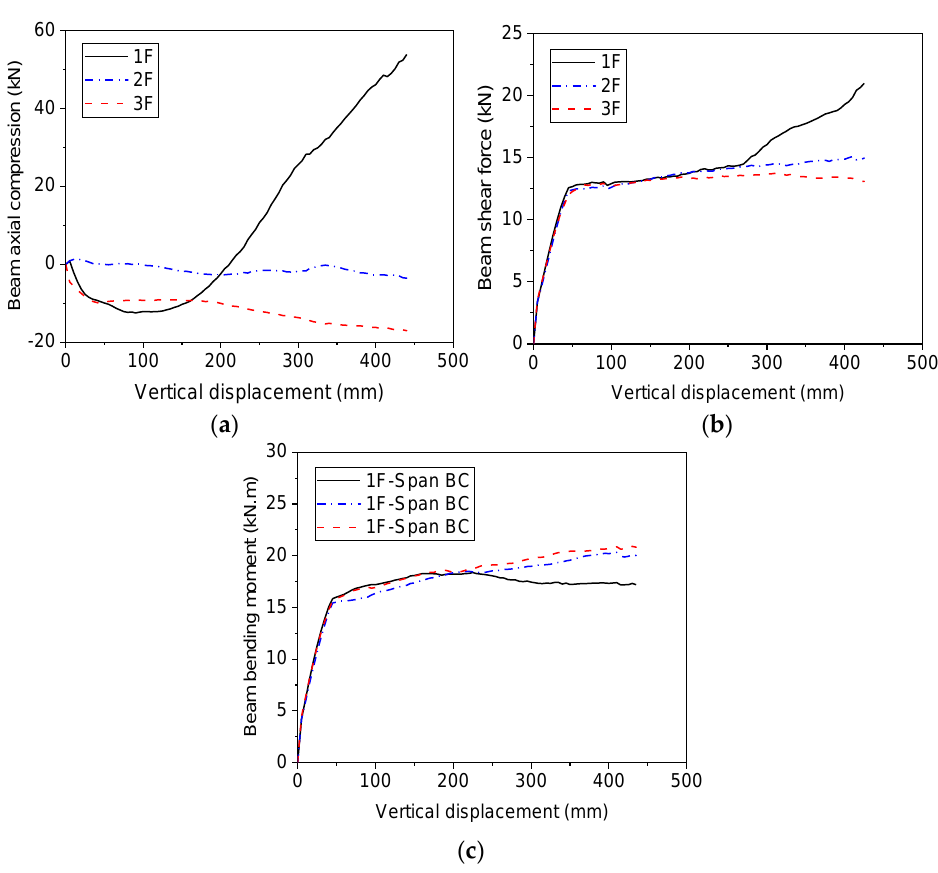
Figure 15. Behaviour of beams at different storeys of three-storey frame: ( a ) axial forces in beams; ( b ) shear forces in beams; ( c ) bending moments in beams.